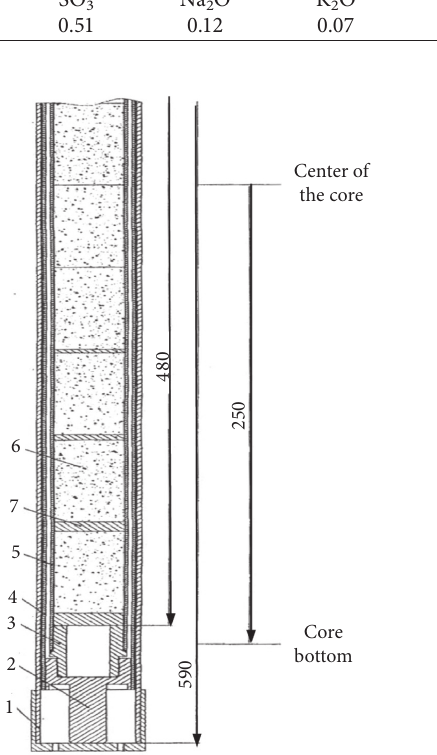
Table 1: Chemical composition of a composite material based on a modified shot of titanium hydride and Portland cement after heat treatment at 300 ° C for 500h. Content [wt. %] TiH 1.8